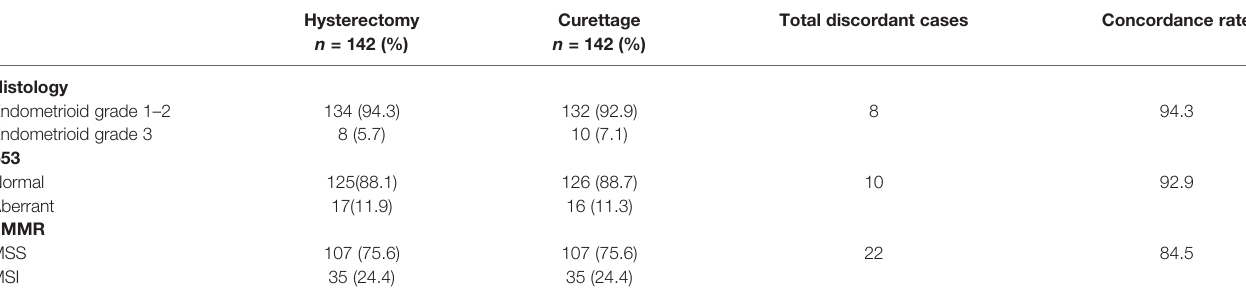
TABLE 4 | Concordance of histopathological features and molecular alterations in endometrial hysterectomy and pre-operative specimens.